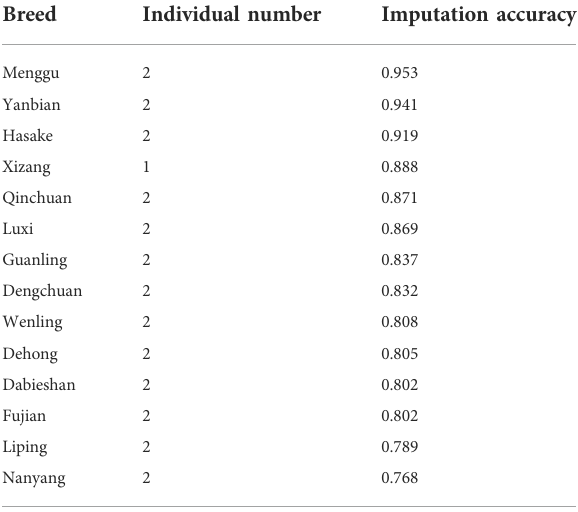
TABLE 4 The imputation accuracy for 27 Chinese yellow